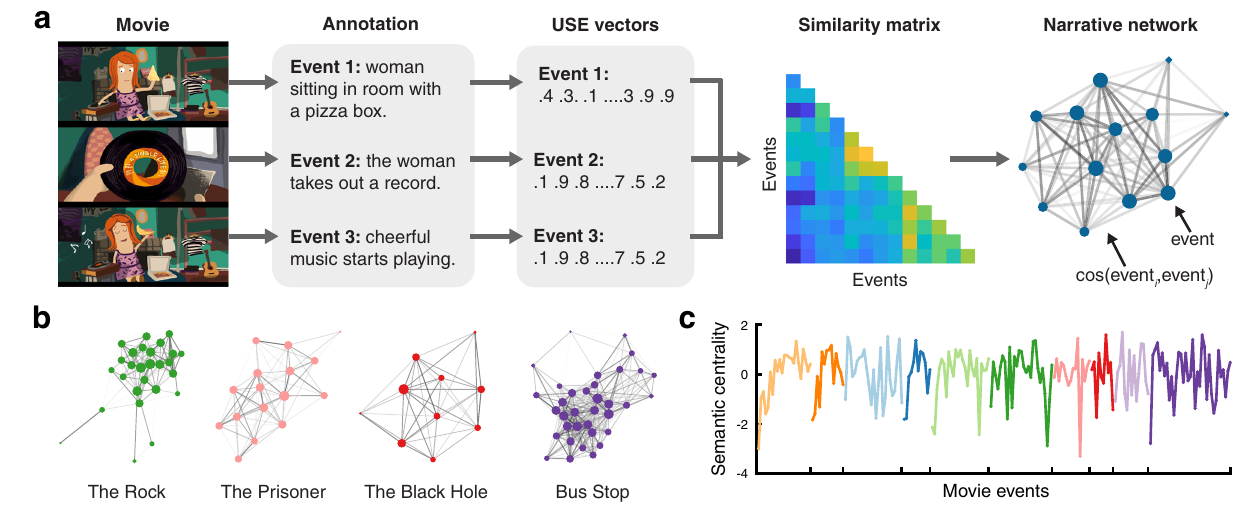
Fig. 1 Semantic narrative networks. a To create semantic narrative networks, each movie was split into events, and independent annotators provided text descriptions of the events. The text descriptions were transformed into sentence embedding vectors using Google ’ s Universal Sentence Encoder (USE) 25 . Semantic similarity between events was computed as the cosine similarity between the USE vectors. A semantic narrative network was de fi ned as a network whose nodes are movie events and the edge weights are the semantic similarity between the events. b Semantic narrative networks of four example movies used in the fMRI experiment. Edge weights were thresholded at cosine similarity = .6 for visualization purposes. Node size is proportional to centrality computed from unthresholded networks. Edge thickness is proportional to edge weights. c Semantic centrality (normalized degree) for individual movie events of the 10 movies used in the fMRI experiment. Different colors denote different movies. Source data are provided as a Source Data fi le. For the semantic similarity matrices and narrative networks of all 10 movies, see Supplementary Fig. 3. Movie scene images in a were created by the author H. L. using Adobe Illustrator